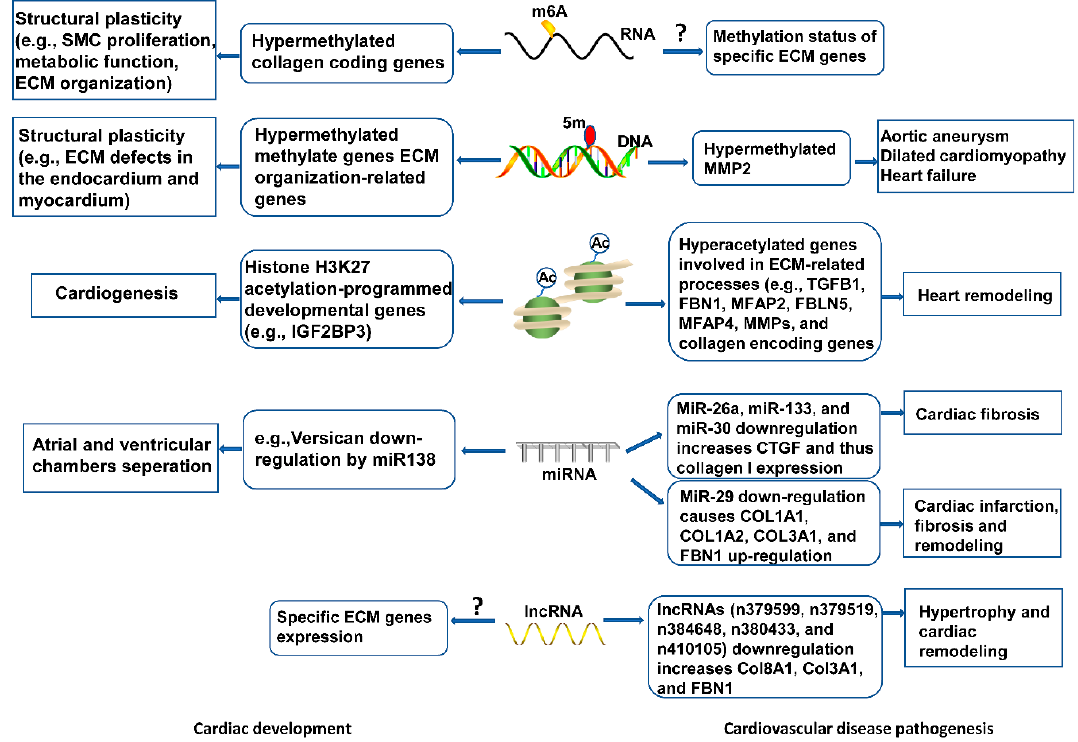
Figure 3. Epigenetic mechanisms of ECM modulation in cardiovascular development and disease. Epigenetic events, including RNA and DNA methylation, histone modifications, and non-coding RNAs mediate ECM gene expression, contributing to cytoskeletal architecture, remodeling, and functional response in heart development. Abnormal epigenetic modification may disrupt ECM homeostasis, leading to cardiovascular pathogenesis.